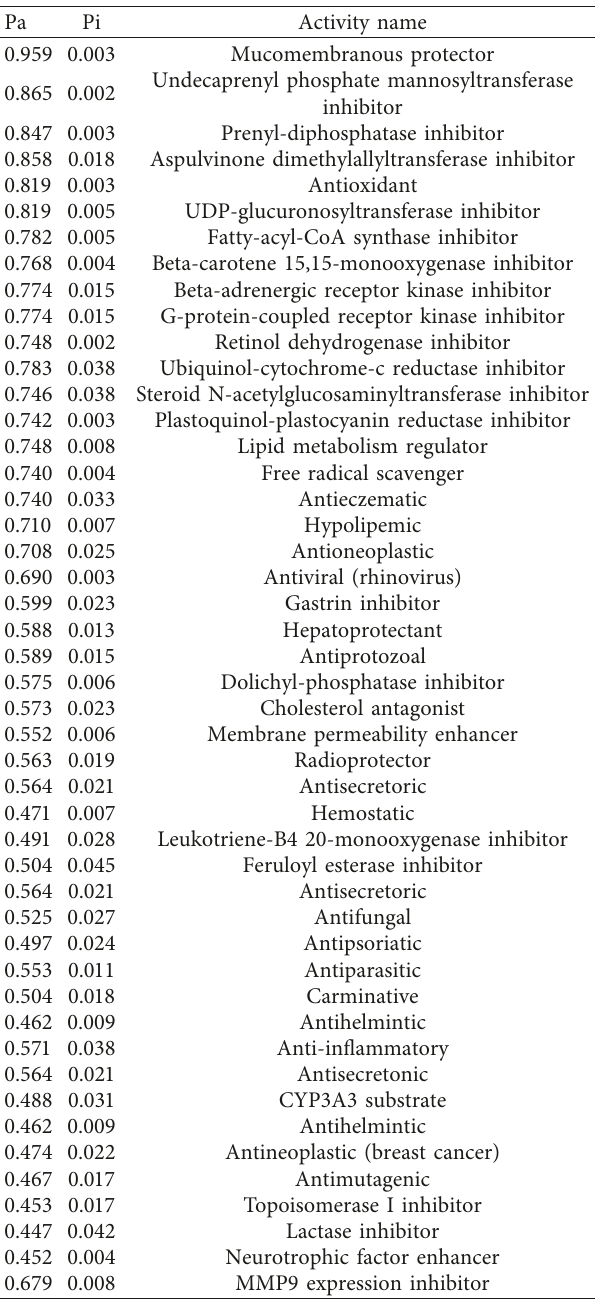
Table 3: PASS prediction for the activity spectrum of 4NRC with Pa >